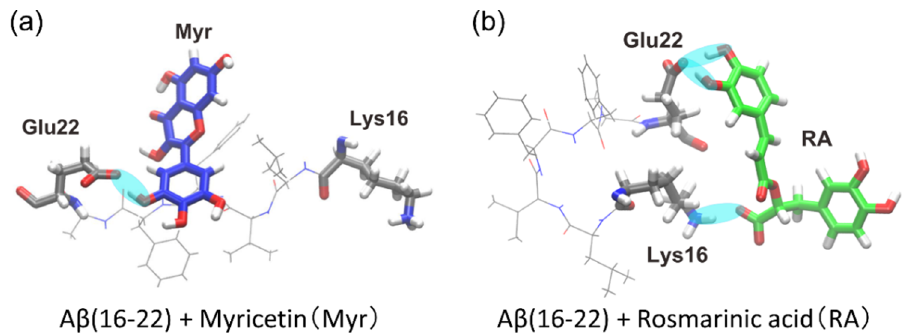
Figure 11. Typical snapshots of the ( a ) Myr system and ( b ) RA system that have hydrogen bonds with the A β (16–22) peptide. Cyan ovals indicate hydrogen bonds. Reprinted with permission from Reference [26]. Copyright 2020 Elsevier.